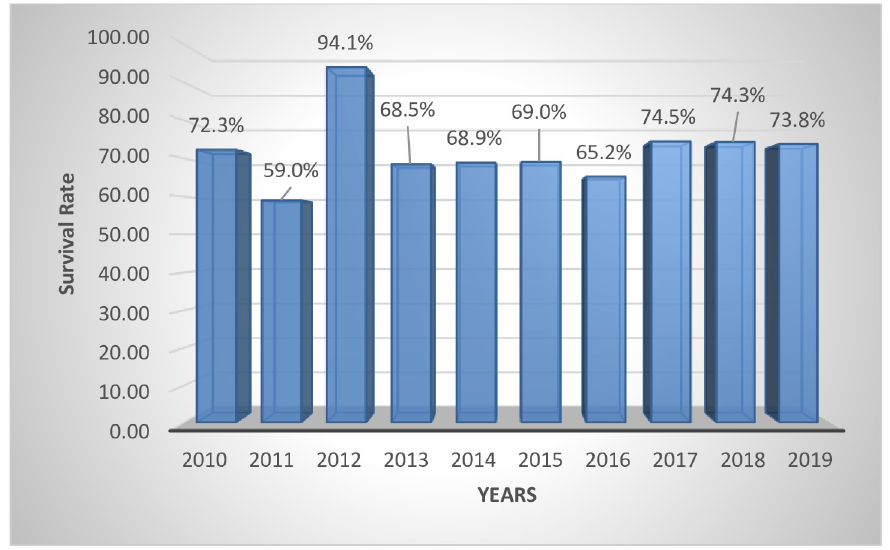
Fig 2. Survival rate of preterm babies for the 10